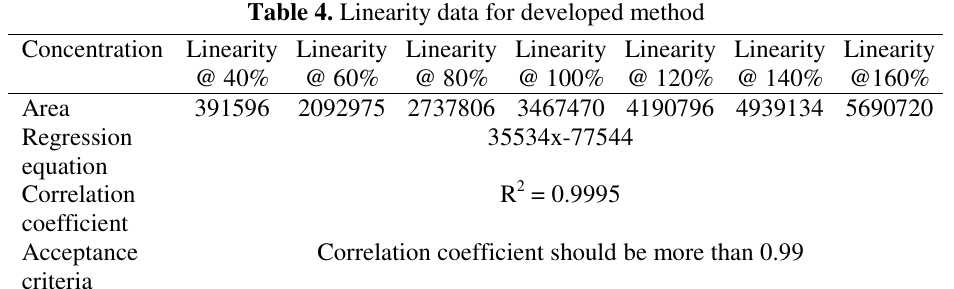
Table 4. Linearity data for developed method